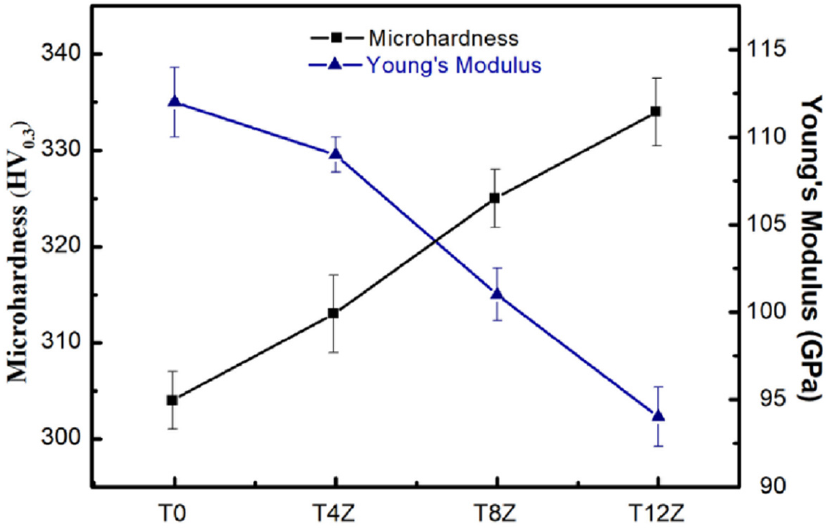
Figure 11. The microhardness and Young’ s modulus of Ti-30Mo-0.5TiC-xZr alloys.